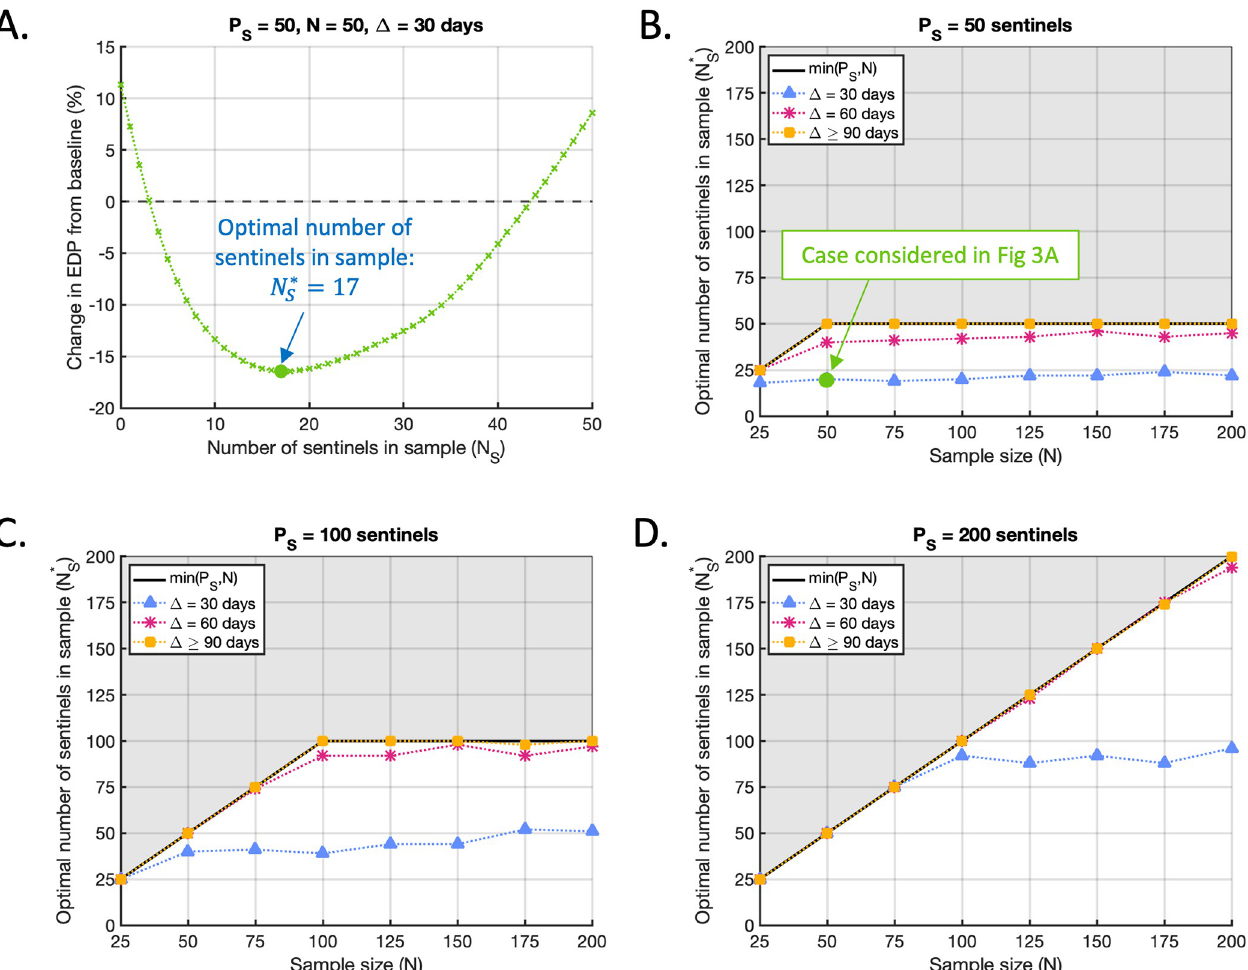
Fig 3. The optimal number of sentinel plants to include in the sample depends on the sample size, sample interval and the total number of sentinels in the population. A. The effect of varying the number of sentinels included in the sample ( N S ) on the percentage change in EDP compared to the baseline level, in the case P S = 50, N = 50, Δ = 30 days. The number of sentinels in the sample for which the reduction in EDP is maximised ( N � green circle. Black dashed line marks the baseline EDP. B. The optimal number of sentinels N � and sample interval ( Δ ) vary. Solid black line marks the maximum possible number of sentinels that could be sampled at any time (min( P marks the unfeasible region in which N S exceeds this maximum. Green circle marks the case considered in A ( P S = 50, N = 50, Δ = 30 days). C. The analogous figure to B, but with P = 100 sentinels added to the population. D. The analogous figure to B, but with P S